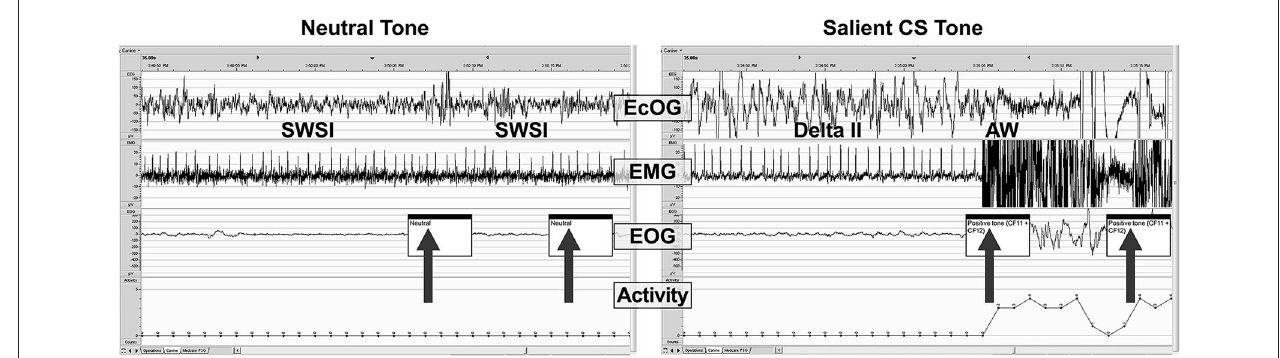
stimuli presentation (arrows). Note that the dog remains asleep during the neutral tone (only ECoG perturbation), but immediately awakens into Active Wake with the salient CS tone. The first 2 tones of a 3-tone/30-s epoch are shown. AW, active wake; ECoG, electrocorticogram; EMG, electromyogram; EOG, electrooculogram; SWSI, slow wave I sleep; delta II, delta II